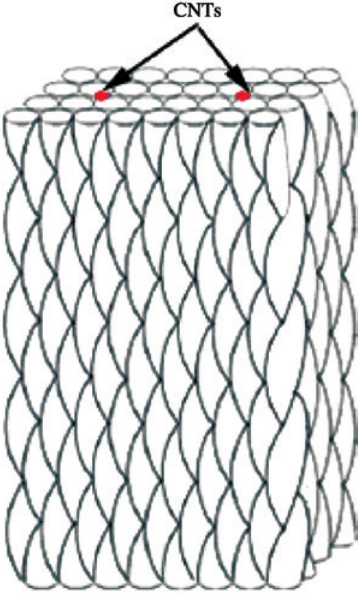
Figure 4: Schematic diagram of 3-D braided composite material preform with